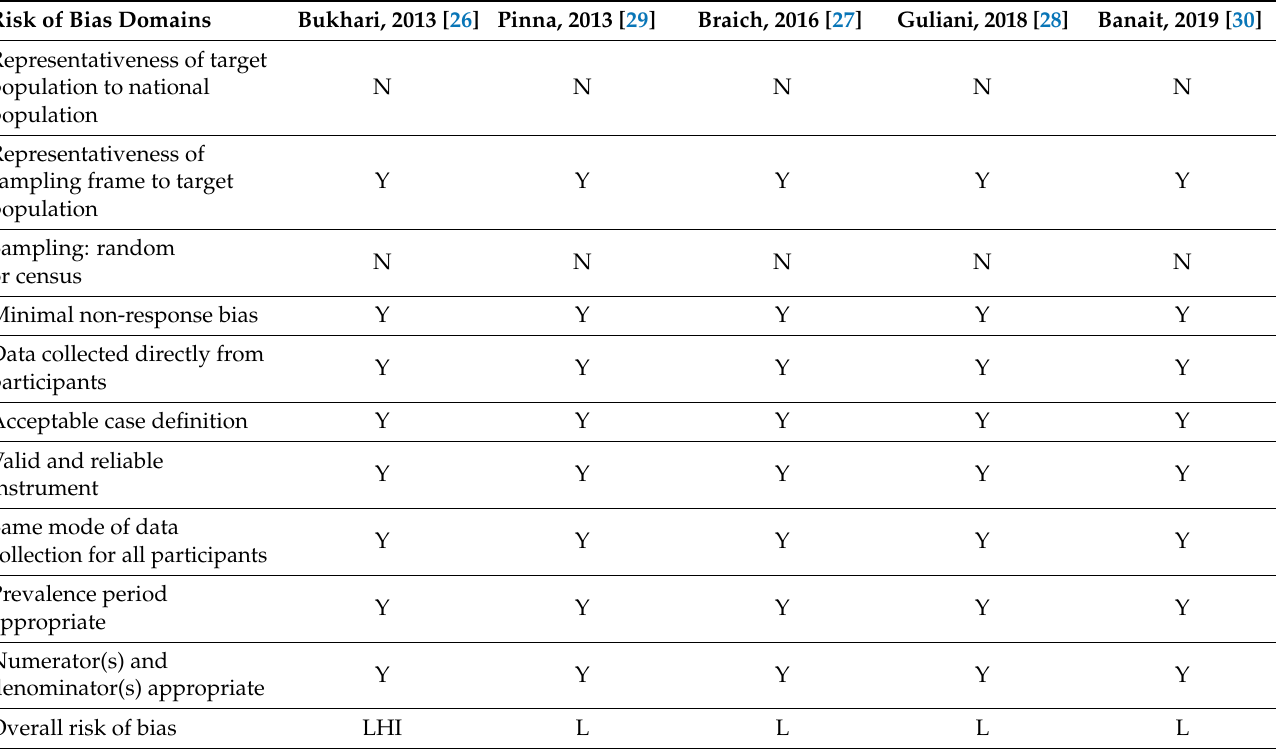
Table 2. Risk of bias assessment for the papers in the